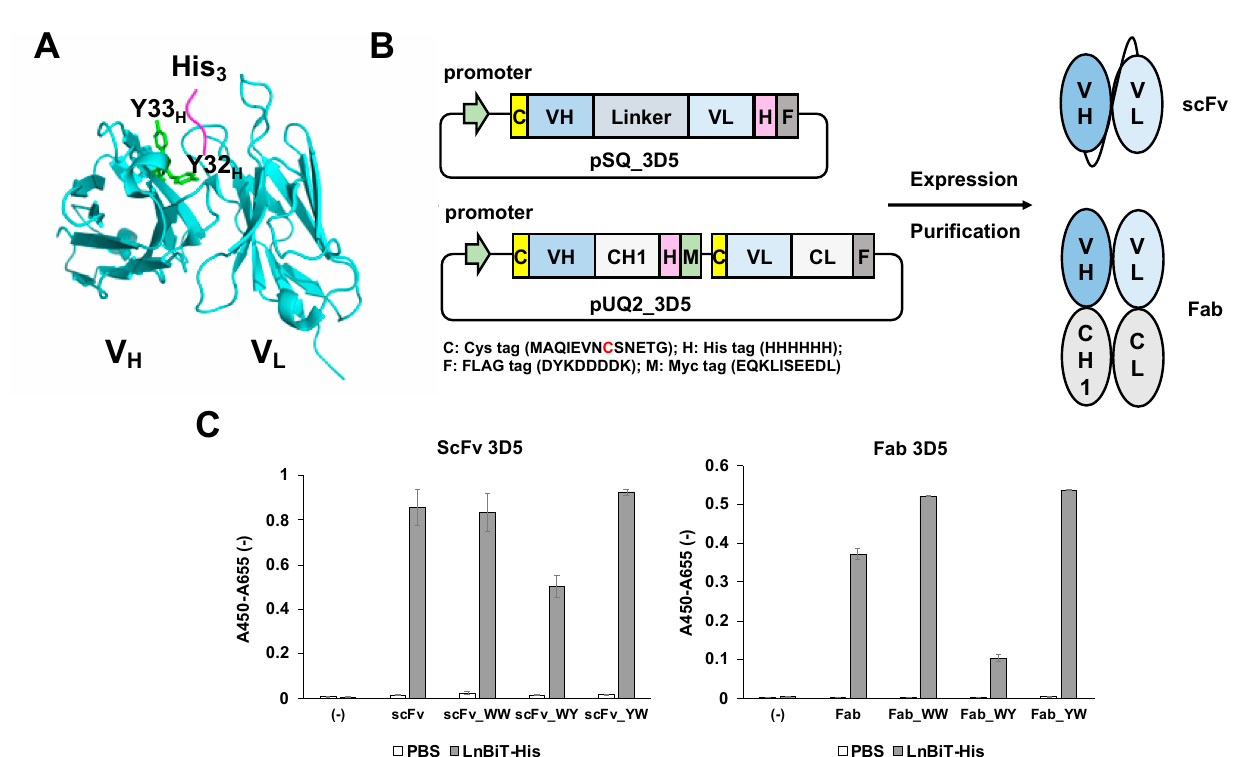
Figure 1. Protein expression and activity of anti-His scFv/Fab 3D5. ( A ) Structure of 3D5 Fv complexed with His6. ( B ) Scheme of the plasmids construction and protein expression for scFv and Fab 3D5 fragments (Figure S1). ( C ) Specific antigen binding of scFv/Fab 3D5 fragments and their variants detected by enzyme-linked immunosorbent assay (ELISA). Gray bars represent the signals with immobilized thioredoxin-fused LnBiT protein with His6 tag at the C-terminus. White bars represent the signals without antigen. Error bars indicate ±1 standard deviation (SD) (n = 3).